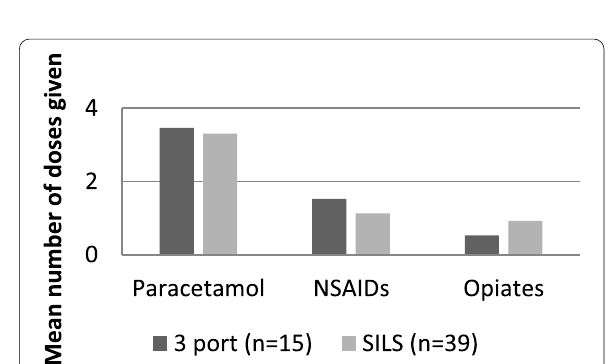
Fig. 4 Post-operative analgesia requirement for overnight stay (24 h postoperatively)